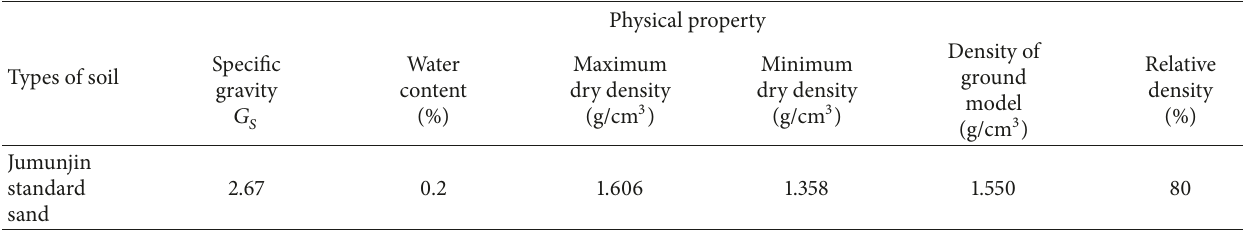
Table 3: Physical properties of Jumunjin standard sand.